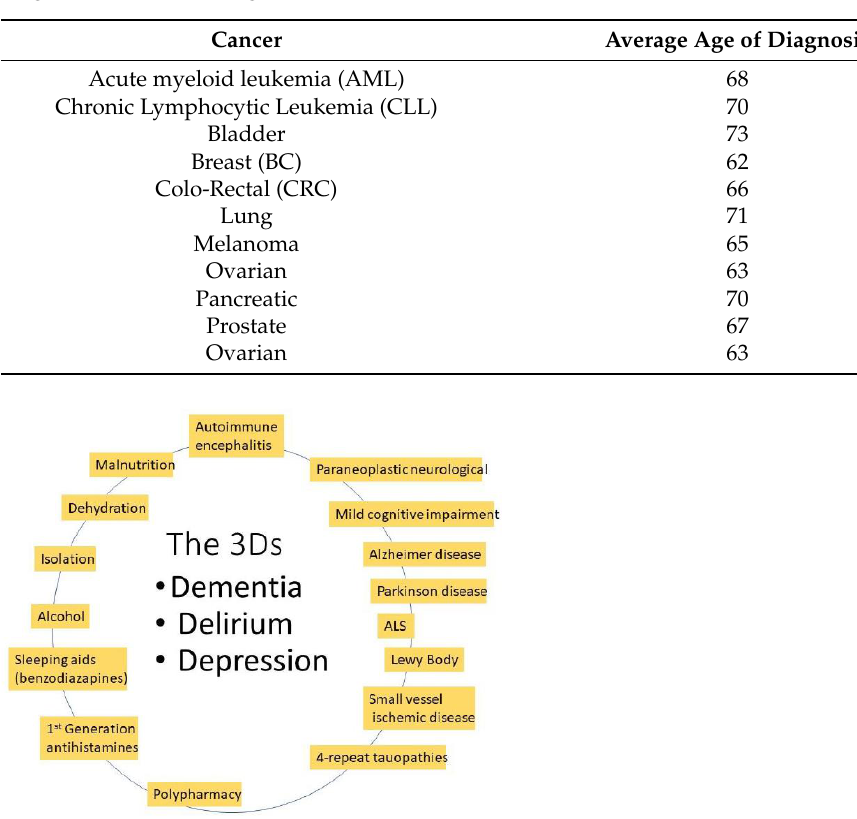
Table 1. More than half of cancers are diagnosed in people older than 60 years. The table lists cancers whose median age of diagnosis is above 60 years. Except for ovarian (54–65), most cases are diagnosed between the ages of 65–74.